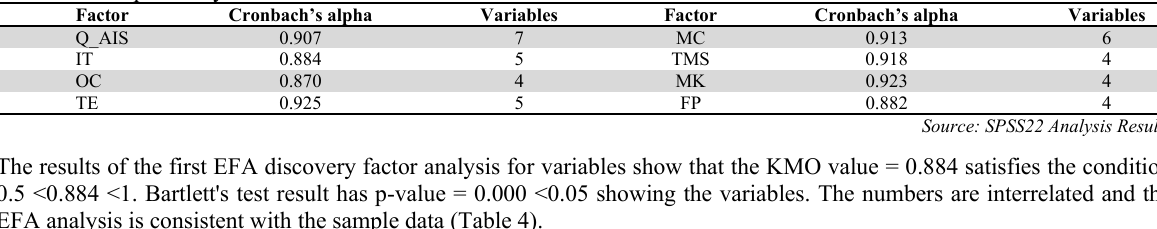
Cronbach’s Alpha analysis results